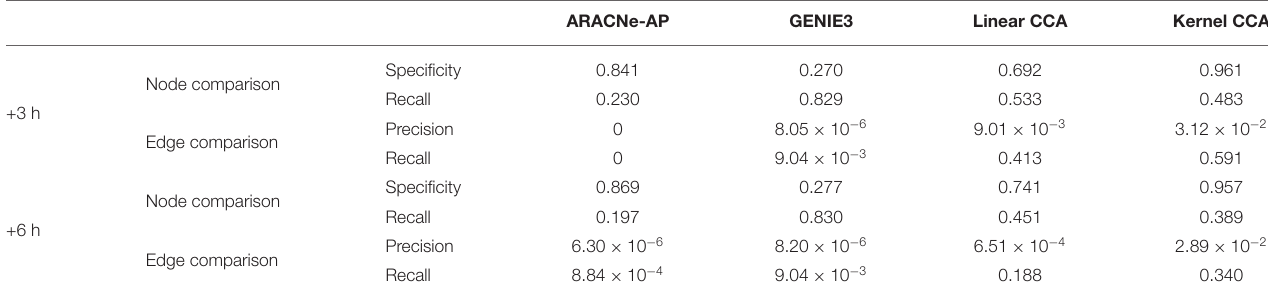
TABLE 1 | Comparison of our method to ARACNe-AP and GENIE3 in terms of specificity, precision, and recall with respect to the ground truth network from a literature search tool, BEST (Lee et al.,